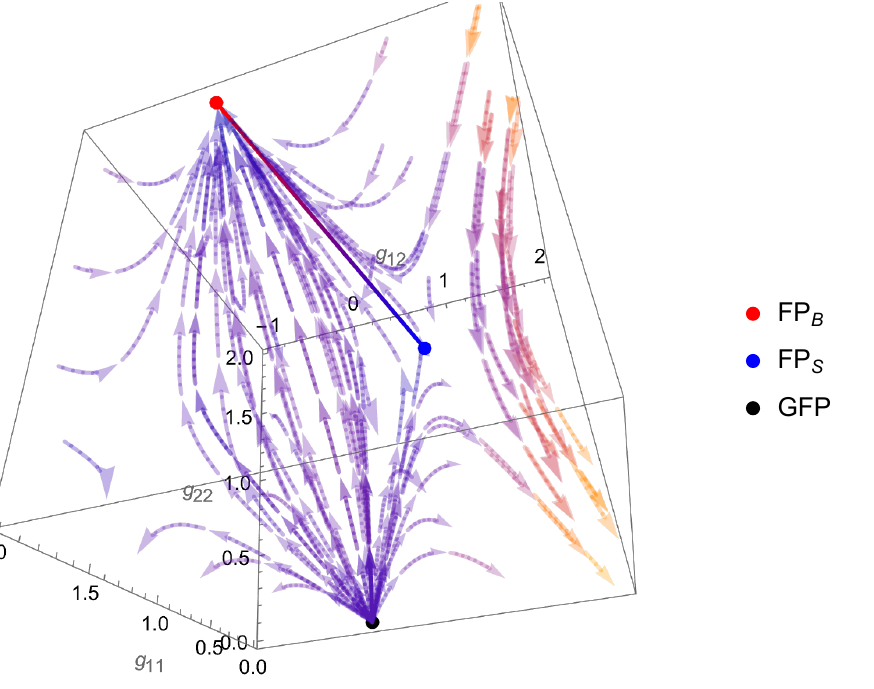
Figure 2 . Streamplot of the RG flow for the bosonic model for the bicritical flow with both ranks equal to 1000. The straight line represents a single step of the type of eq. (3.9). The direction of the flow is following the directions of the arrows, or equivalently from blue to red on the highlighted single-step trajectory. The fixed points FP S (resp. FP B ) corresponds to the fixed point of the (un)broken configuration, while GFP represents the Gaussian fixed point of zero